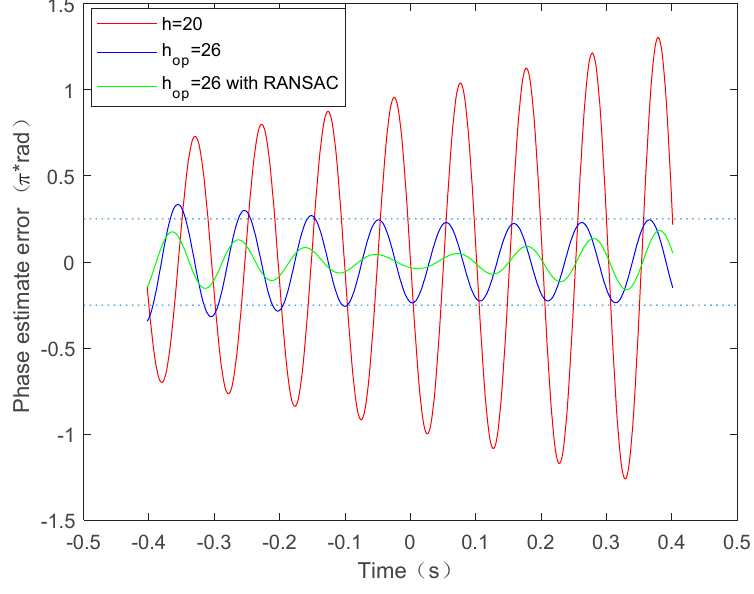
Figure 7. Phase estimate error.